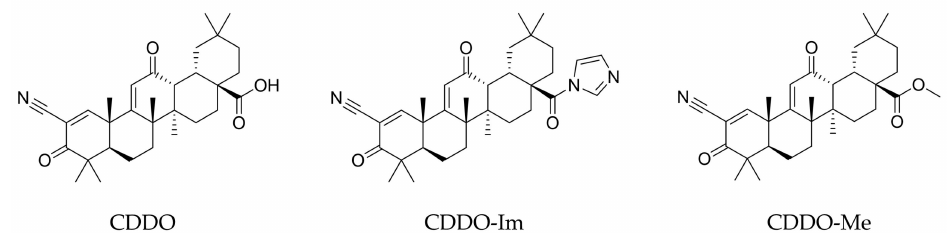
Figure 5. Structures of synthetic triterpenoid CDDO and its derivatives, CDDO-Im and